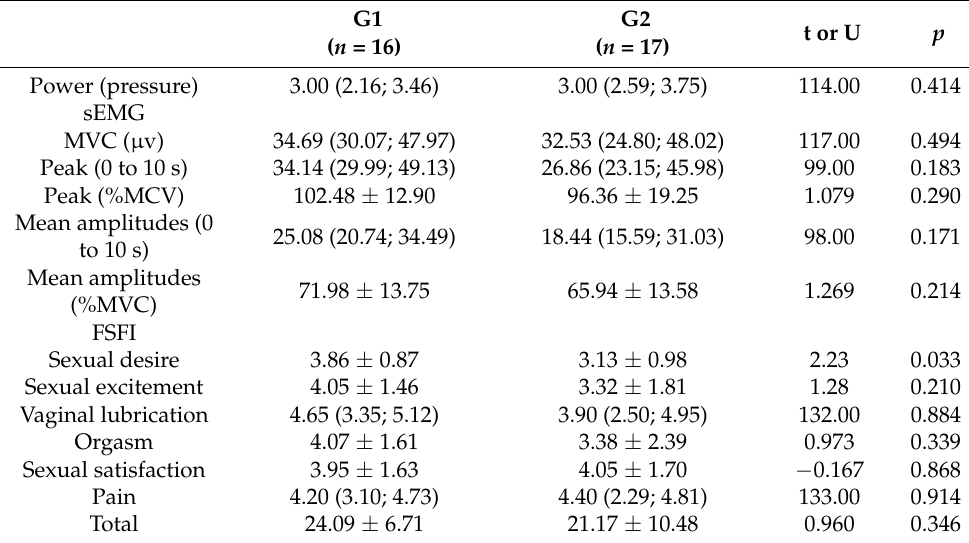
Table 1. Level of strength and bioelectrical activity of the pelvic floor muscles and sexual function in women with stress urinary incontinence (G2) in relation to the control group (G1).